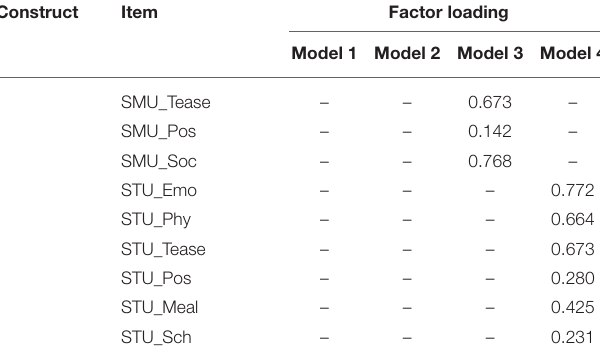
TABLE 3 | Factor loadings of all instrument items in each proposed model.